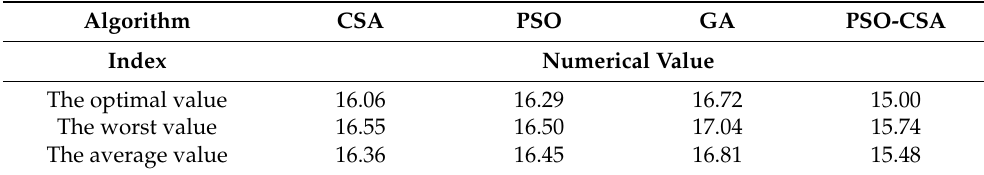
Table 3. The optimal value, the worst value and the average value of the fitness function of the four algorithms in the process of running 30 times.